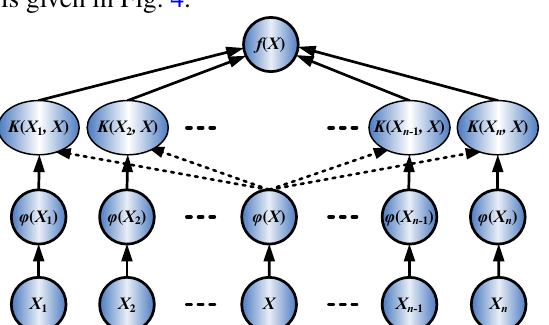
Fig. 4. Prediction function structure of